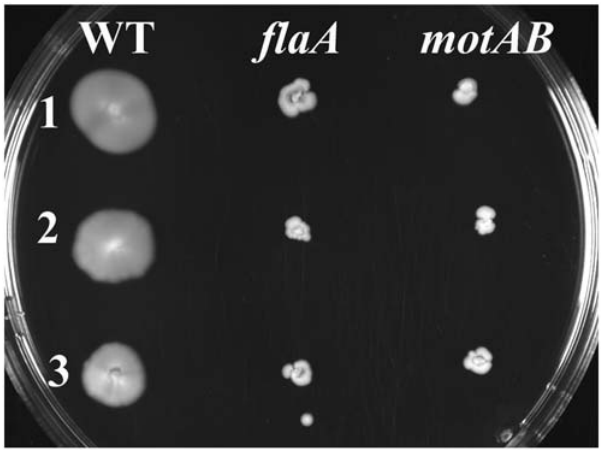
Figure 1. Colony spread of strains in soft agar. Strains were toothpicked onto BHI + 0.4% agar, and grown at 30 u C. Row 1 contains strains in the 10403 background, Row 2 contains strains in the RM2387 background, and Row 3 contains strains in the RM2992